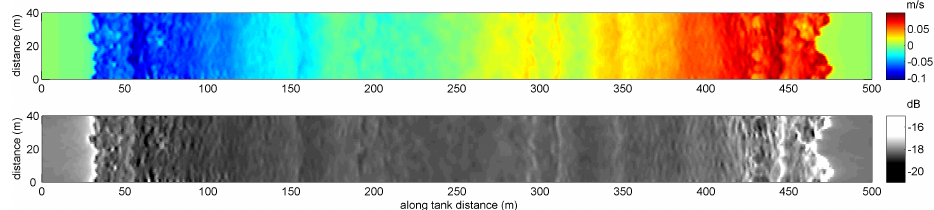
Figure 8. Surface signature of low-density plume in the velocity field (top, in ms − 1 ) and radar backscatter intensity map (bottom; NRCS, dB values here should be taken as relative range). The x axis shows along-tank distance; y axis is across-tank distance (in m). Taken at time t = 2850s.